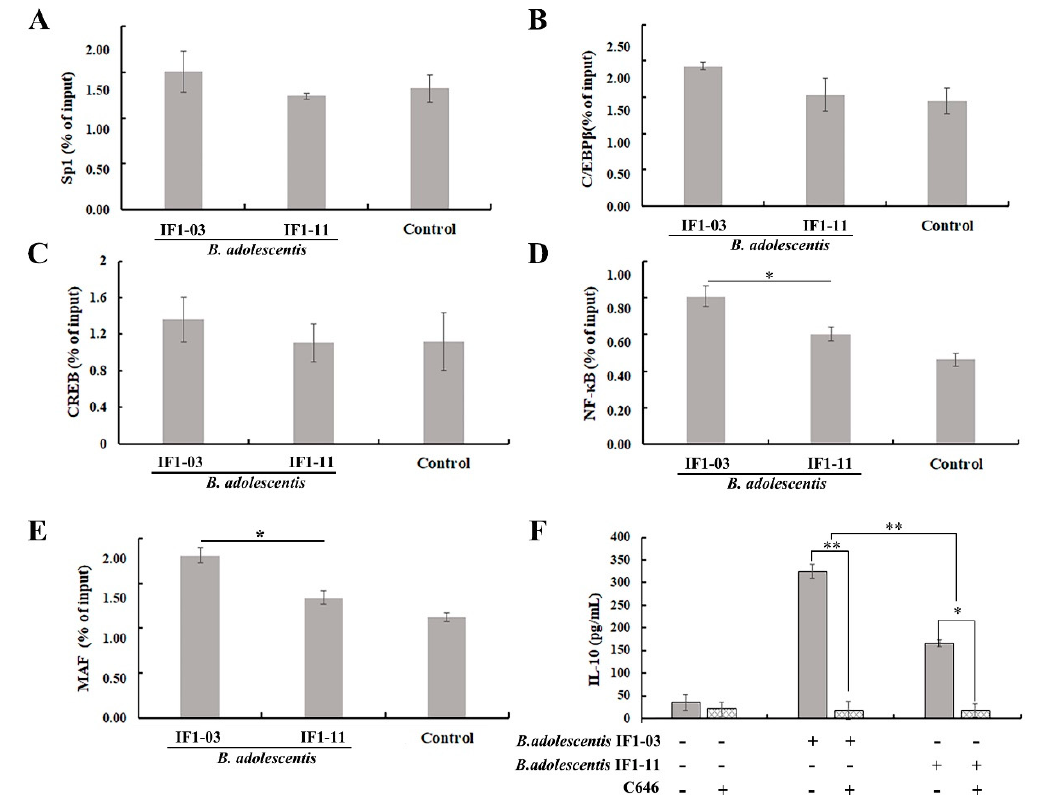
Figure 6. B. adolescentis strain-stimulated RAW264.7 macrophages show active chromosome remodeling related to targeted gene promoter combination with transcriptional factors NF- κ B and others, and IL-10 production. Macrophages were stimulated with B. adolescentis IF1-11, B. adolescentis IF1-03 or left untreated for 3 h (control) and the level of H3K9 acetylation on sites of transcription factor–genomic DNA interaction sequence at the Il10 proximal promoter locus was determined by qPCR with specific primers (Table 1). ( A ) Sp1, ( B ) C/EBP β , ( C ) CREB, ( D ) NF- κ B, ( E ) MAF, and ( F ) IL-10 yield in macrophages treated with B. adolescentis strains, and inhibition of H3K9 acetylation with C646. IL-10 was assayed by ELISA. Data are shown as mean ± SD for three independent experiments (* p < 0.05, ** p < 0.01). Sp1: Specific protein 1, C/EBP β : CCAAT/enhancer binding protein β , CREB: c-AMP responsive element binding protein, NF- κ B: Nuclear factor κ B.